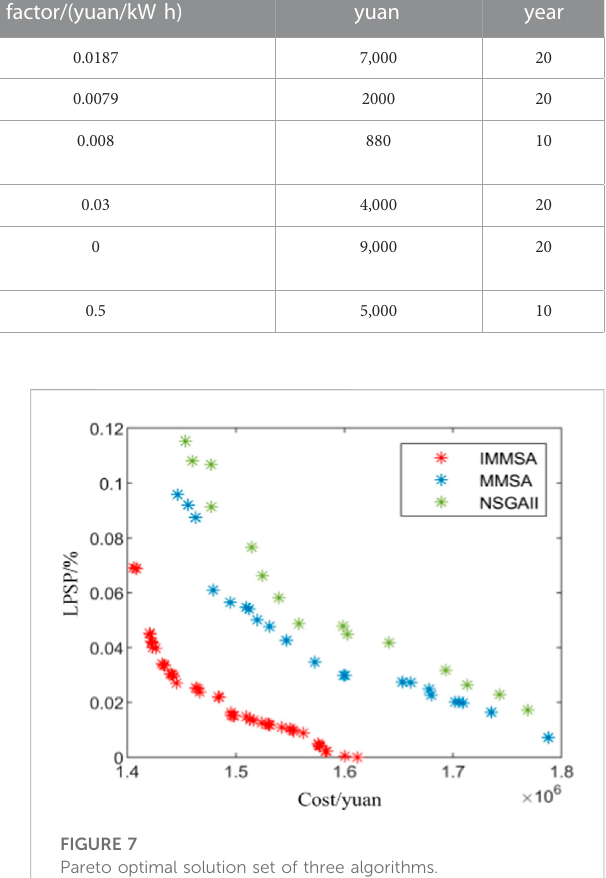
FIGURE 7 Pareto optimal solution set of three